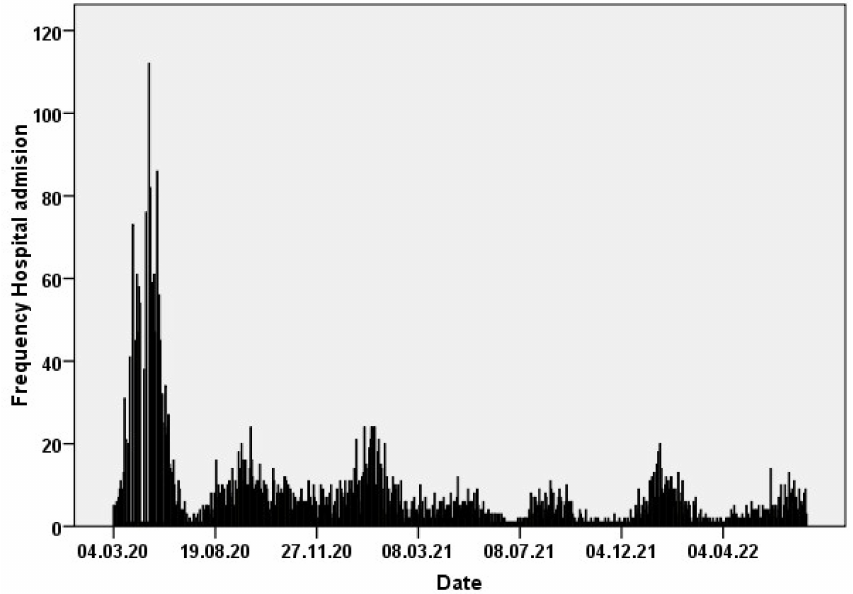
Figure 1. COVID-19 pandemic and hospital admissions in the area of